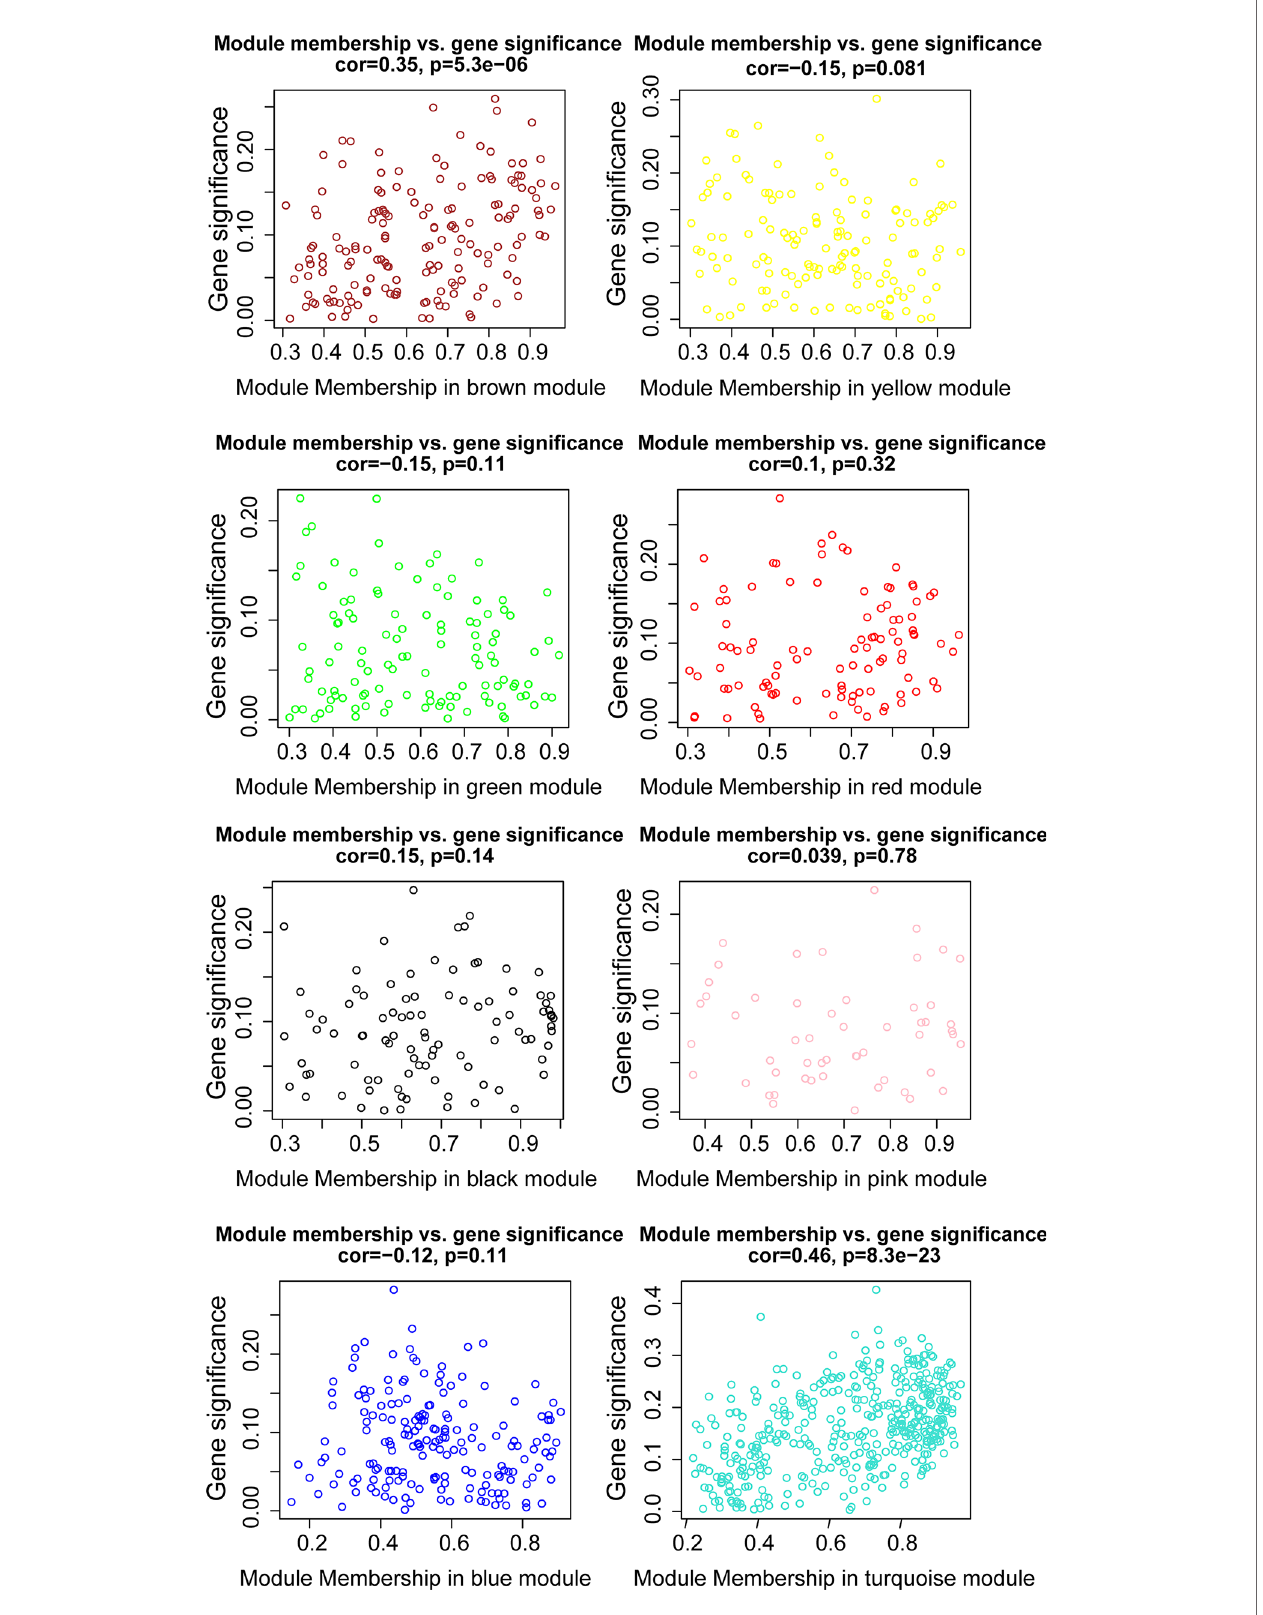
FIGURE 11 | The relationships between the radiomic signature and genes in eight modules. The turquoise modules was highly associated with radiomic risk score and the genes that were selected for further analysis.